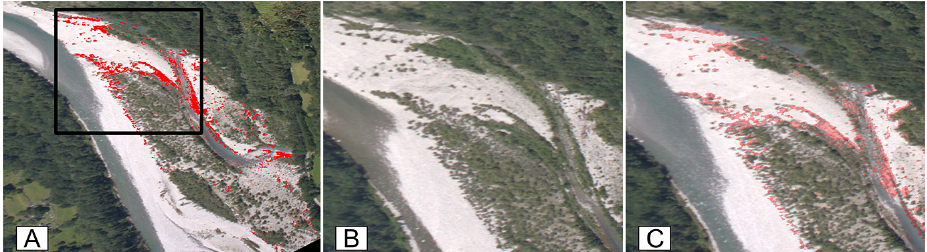
Figure 8. Spatial detail of the upstream section of the study reach with predicted vegetation scour (non-transparent/transparent red colour) after the flood in July 2011 shown together with the actual distribution of vegetation on the surface: (a) full view of the study reach with estimated vegetation scour, (b) detail of pre-flood distribution of vegetation, image from 11 July 2011, (c) detail of post-flood distribution of vegetation, image from 22 July